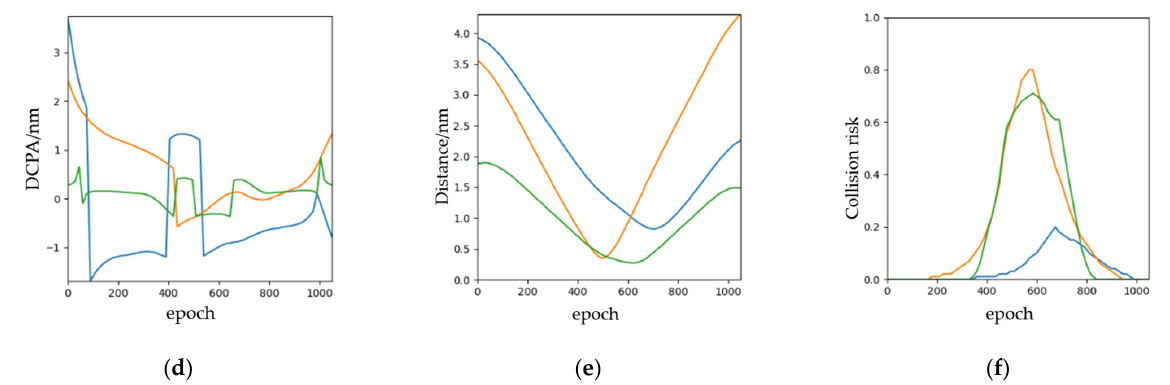
Figure 12. The experimental results (multi-ship encounter in a busy sea area): ( a ) the start time during the collision avoidance process; ( b ) the middle time during the collision avoidance process; ( c ) the end time during the collision avoidance process; ( d ) DCPA; ( e ) distance; ( f ) collision risk (Some subgraphs include some Chinese name and number information of navigation lights in channel, which is inherent in the system of ECDIS and has no influence on the conclusion of this paper).